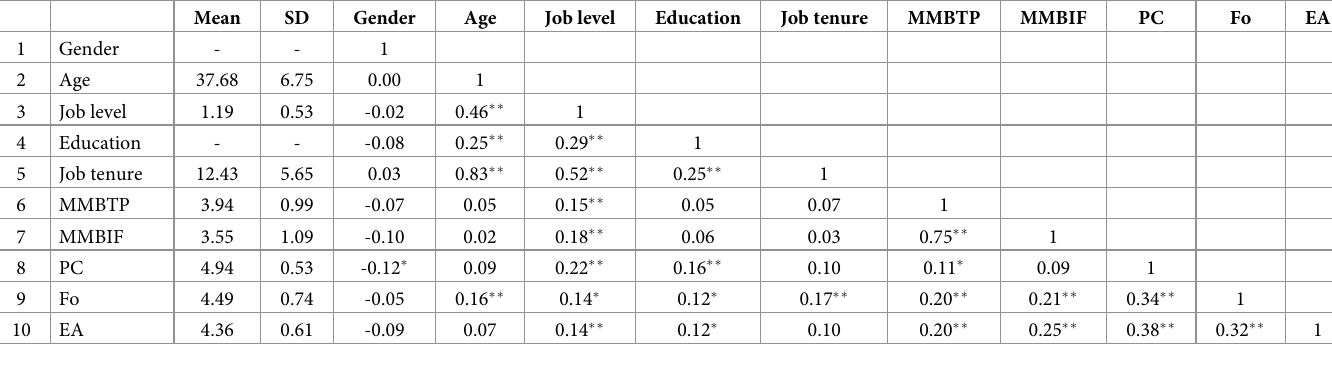
Table 4. Mean, standard deviation, and correlation.